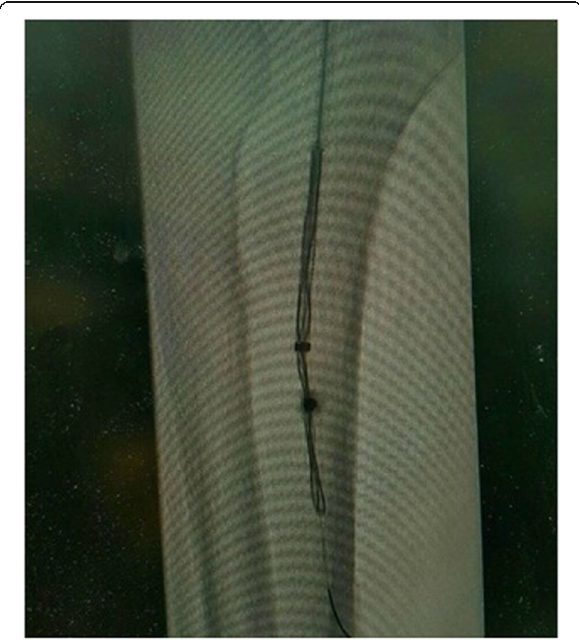
Fig. 2 Attempting an endovascular retrieval of the closure device using a snare (Indy OTW ™ Vascular Retriever, 8Fr, .35 mm, 100